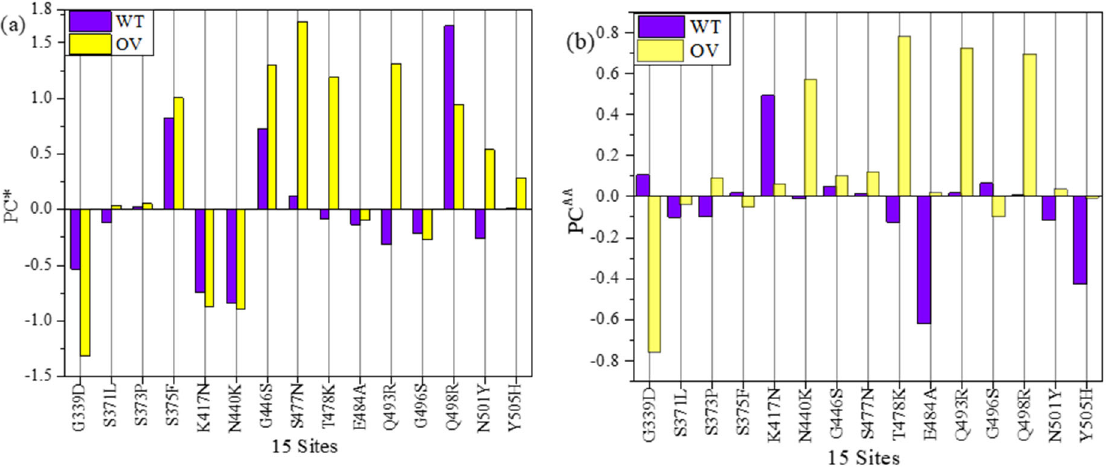
Figure 9. ( a ) Partial Charge per AABPU (PC*) and ( b ) Partial charge per AAs (PC AA ) for 15 muta ‐ tion sites in RBD domain of the RBD ‐ ACE2 interface model. sites in RBD domain of the RBD-ACE2 interface